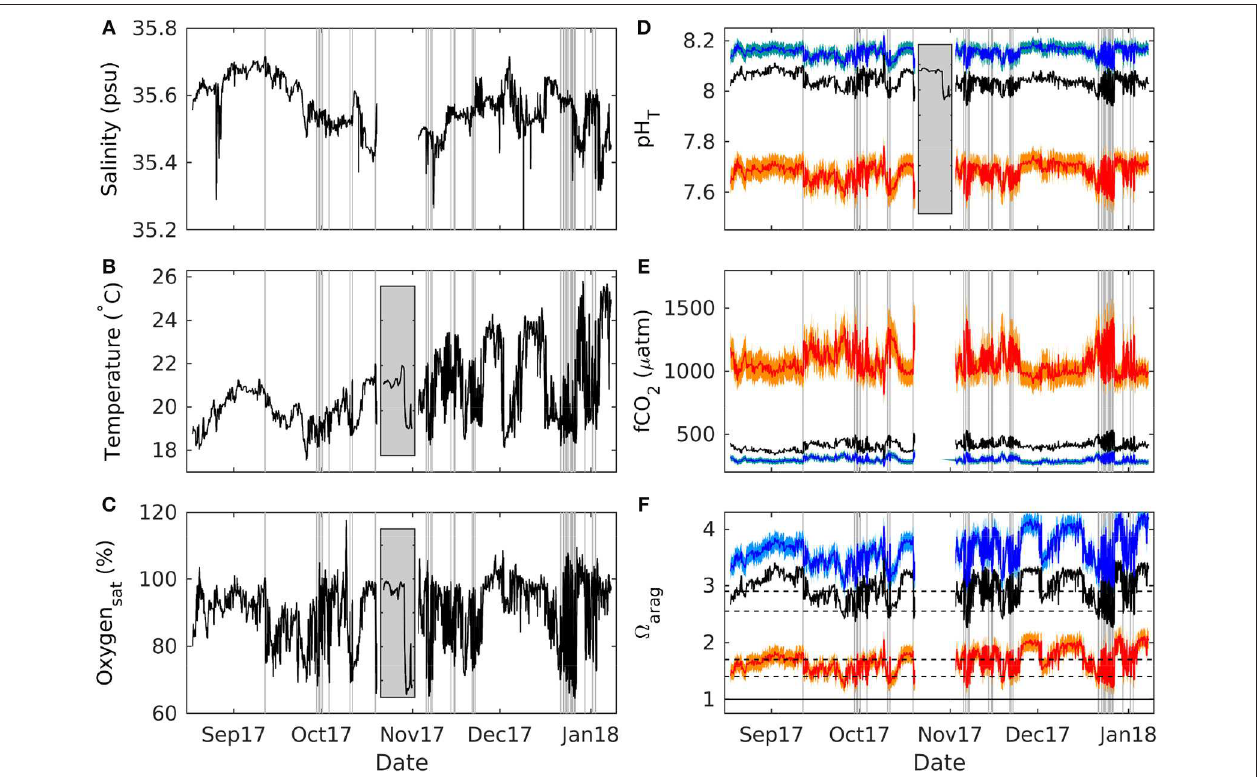
FIGURE 2 | Measured present day, and calculated preindustrial and future upwelling. Variability in measured salinity (A) , temperature (B) , oxygen saturation (C) , and pH on the total scale (D) , together with calculated CO 2 fugacity (E) and aragonite saturation state (F) at the mooring site in Cape Byron Marine Park. Black lines illustrate measurements between August 18 th 2017 and January 8 th 2018, while blue and red lines denote estimated variability for a preindustrial and future (RCP8.5) ocean, respectively, with lighter colors highlighting uncertainty bounds (see Methods for details on calculations). Gray vertical lines denote all major upwelling events (see text for details). The gray insets in (B–D) present a close up of temperature, oxygen and pH changes during an upwelling event on the last 2 days of the first deployment. Black horizontal lines in (F) denote various aragonite saturation state thresholds (see text and Table 1 for